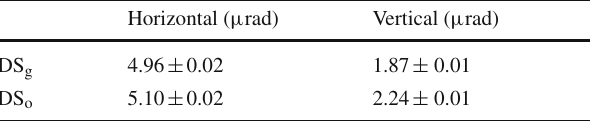
Table 2 Horizontal and vertical angular resolutions of the analysis data sets DS g and DS o , respectively Horizontal ( µ rad) Vertical ( µ rad)